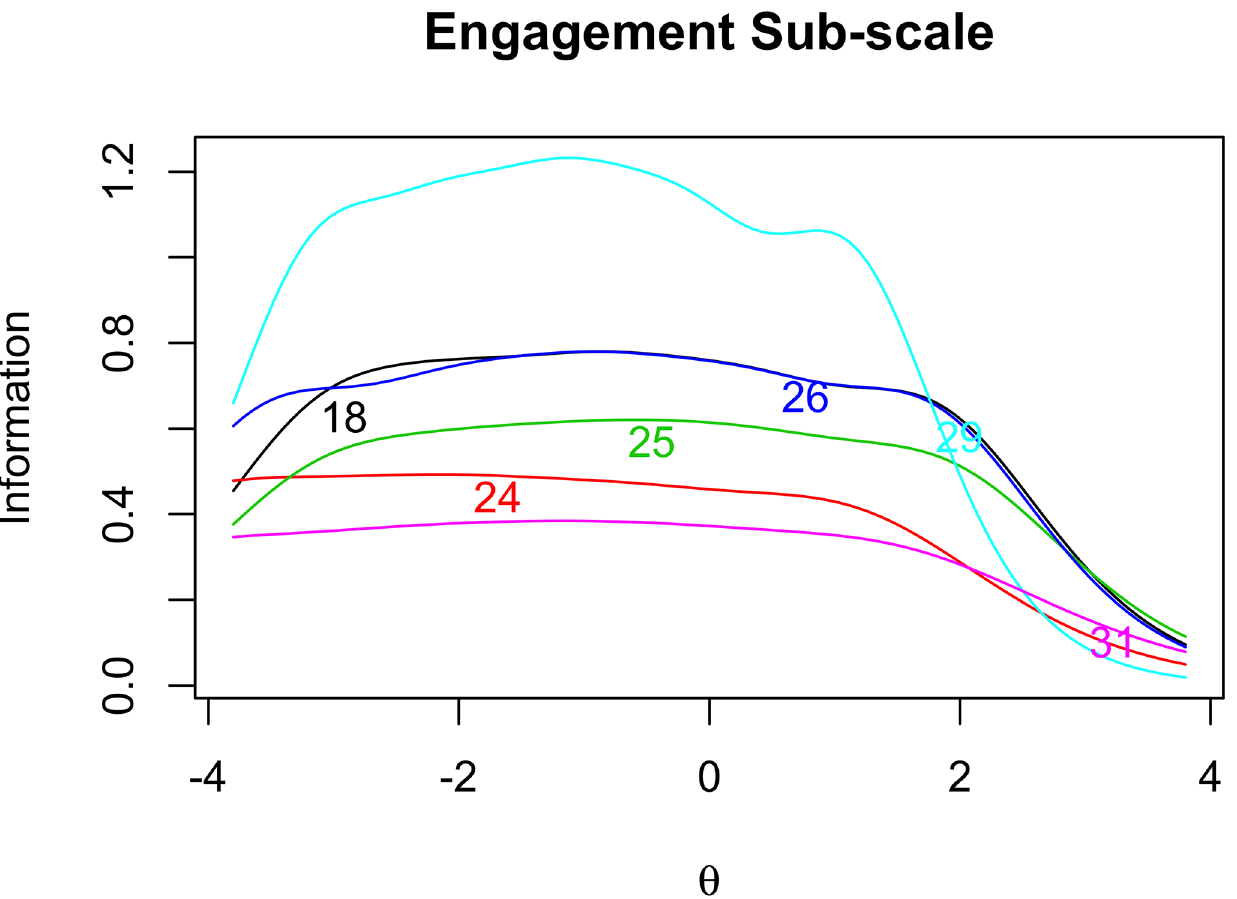
Fig 4. Engagement item response analysis. Item informationfunctions for Engagement